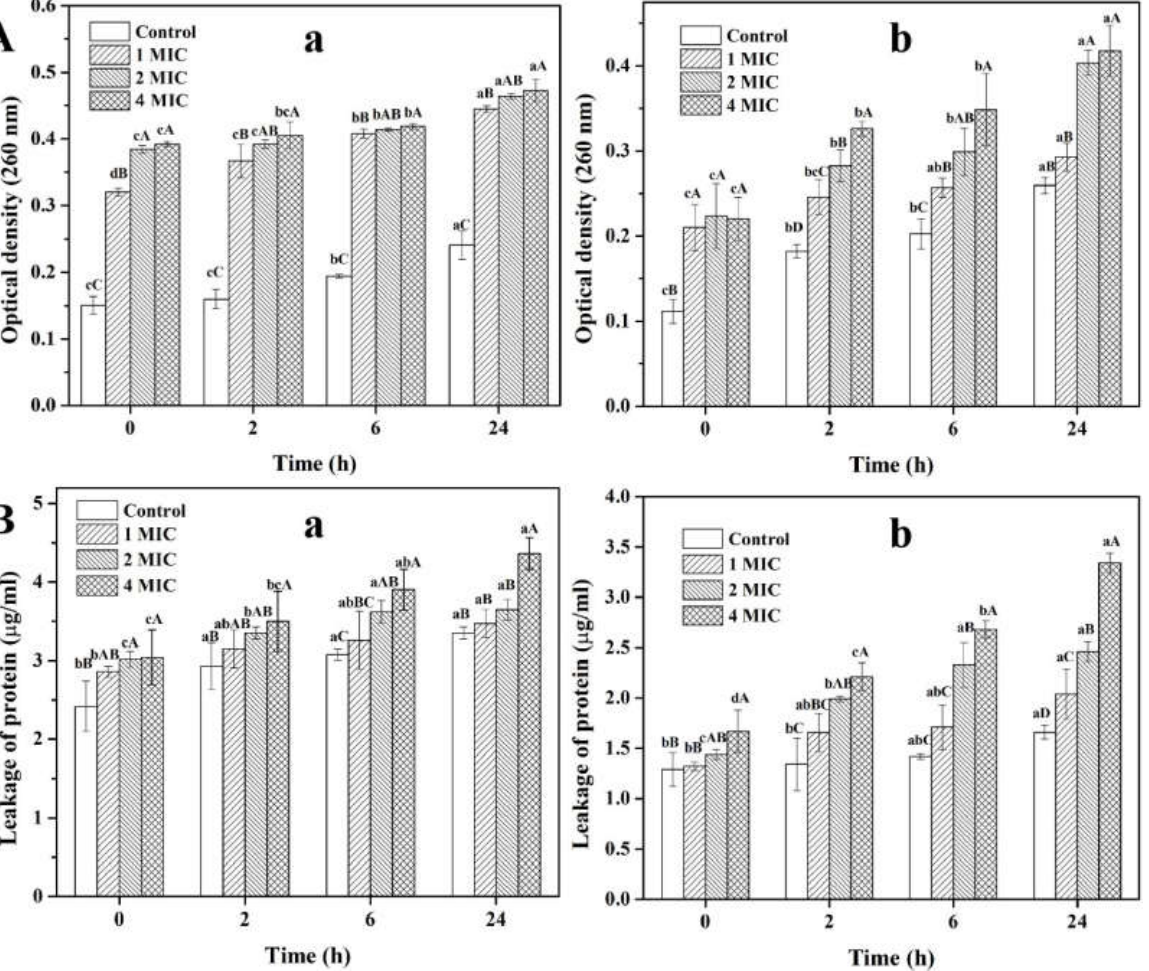
Figure 6. Total nucleotide leakage ( A ) and total protein leakage ( B ) from S. aureus (a) and P. fluo- rescens (b) treated by succinic acid. Different lowercase letters indicate significant difference among treatments at different exposure time ( p < 0.05), while different capital letters indicate significant difference among treatments at different concentrations of succinic acid ( p < 0.05).